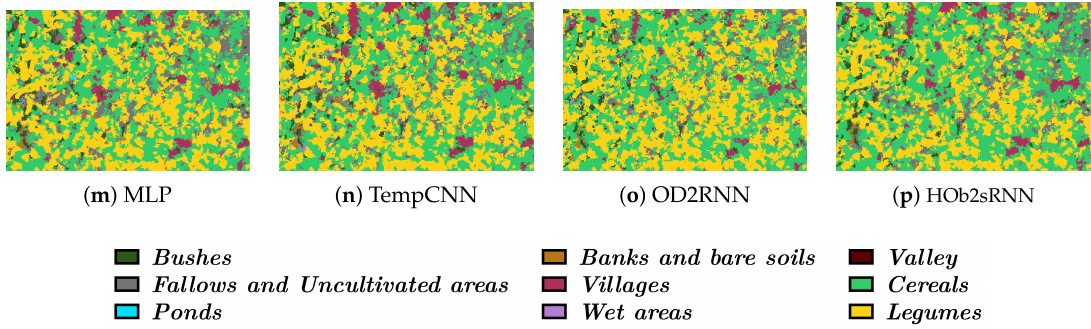
Figure 15. Qualitative investigation of land cover map details produced on the Senegalese study site over heterogeneous landscapes including buildings, agricultural, and wet